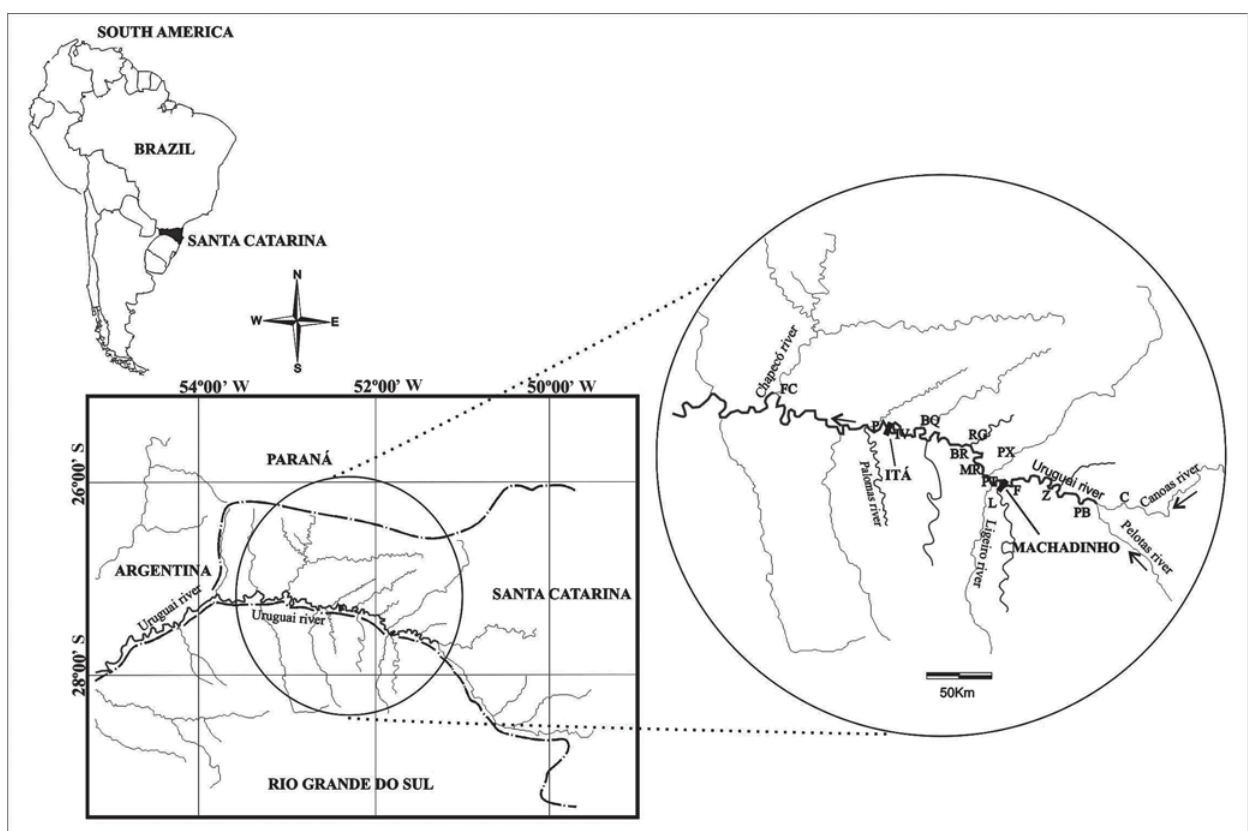
Fig. 1. Location of sampling sites in the upper Uruguay River. PB = Pelotas Barracão, Z = Zortea, F = Forquilha, RG = Rancho Grande, BQ = Barra dos Queimados, BR = BR-153, IV = Itá Velha; C = Canoas, PX = Peixe, MR = Marcelino Ramos, PT = Pelotas Túneis, L = Ligeiro, P = Palomas, and FC = Foz do